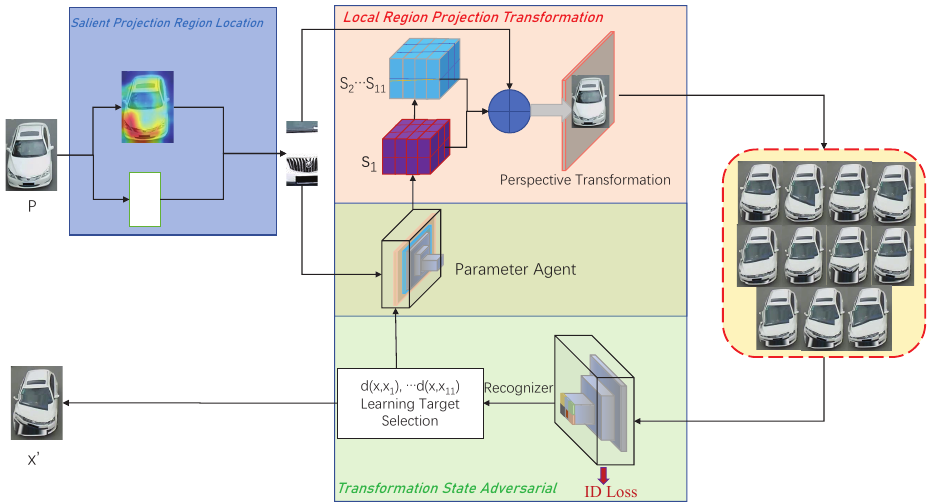
Figure 2. Overall framework. This framework has three parts: Salient Projection Region Location (blue part). Local Region Projection Transformation (red part). Transformation State Adversarial Module (green